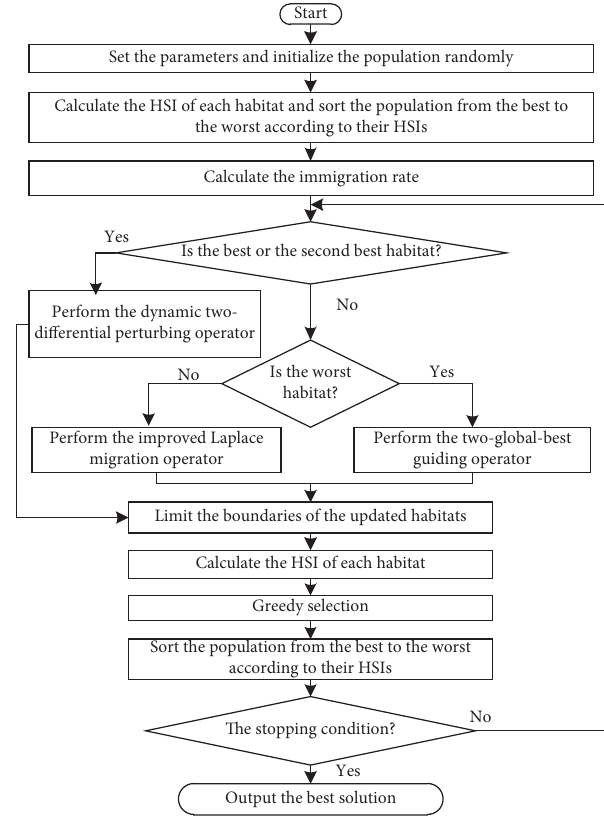
Figure 3: Flowchart of